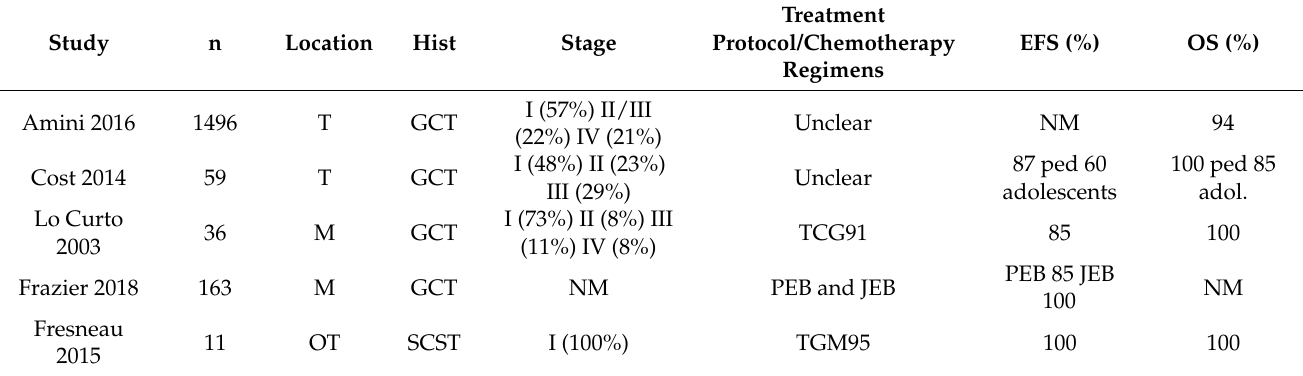
Table 2. Details on the studies of testicular